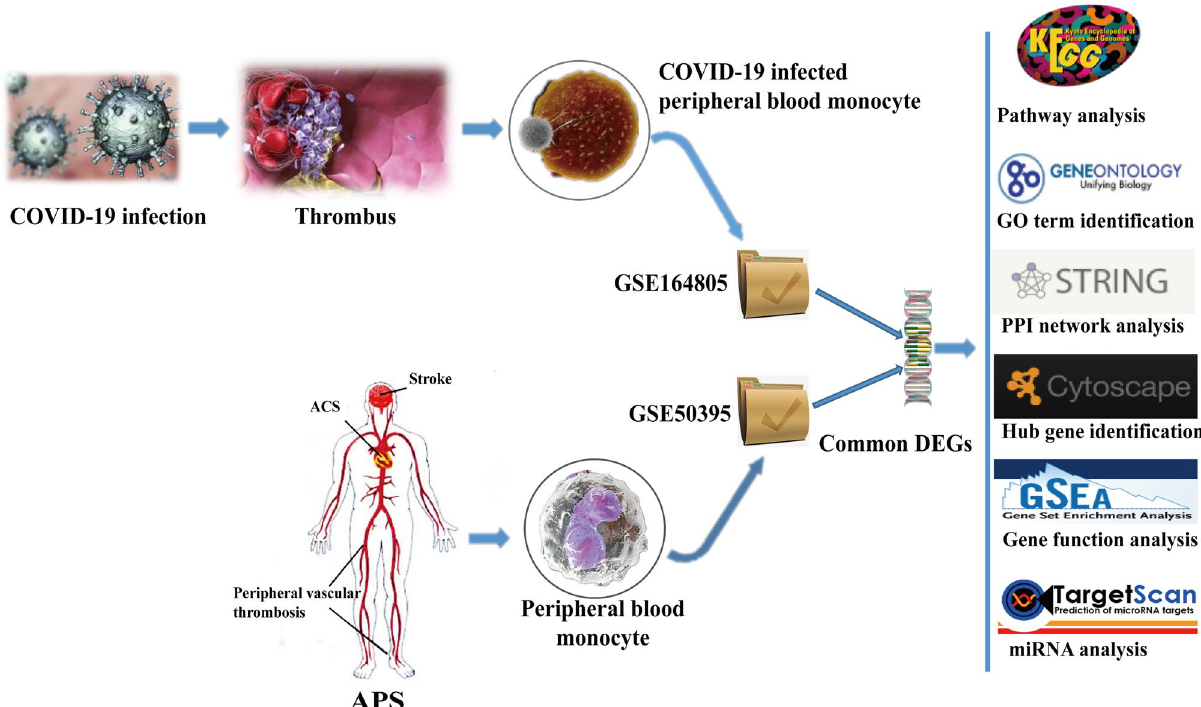
Figure 1. Workflow of the current investigation. Mononuclear cell samples were collected from peripheral blood of patients with severe COVID-19 included in the GSE164805 dataset. The GSE50395 dataset contains